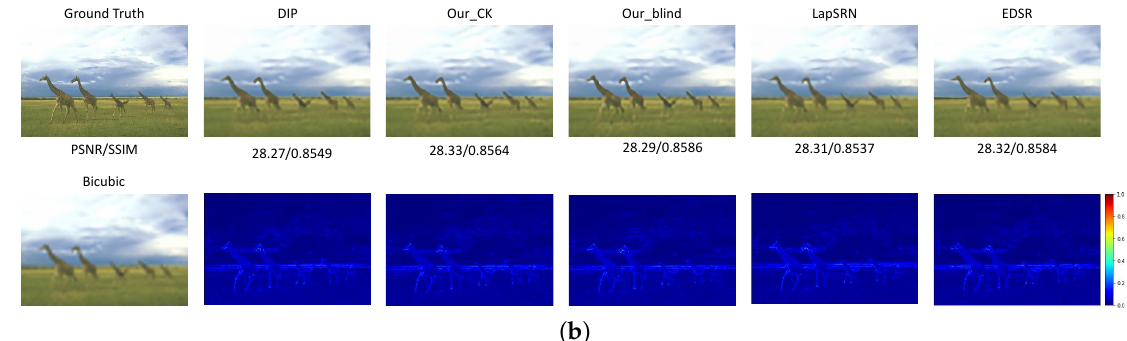
Figure 4. Compared visualization results of the recovered HR images with different SoTA methods. The first row denotes the resulted HR images while the second row gives the difference in images between the recovered and the ground truth images. ( a ) The ’ppt3’ image in Set14. ( b ) The ’253055’ image in